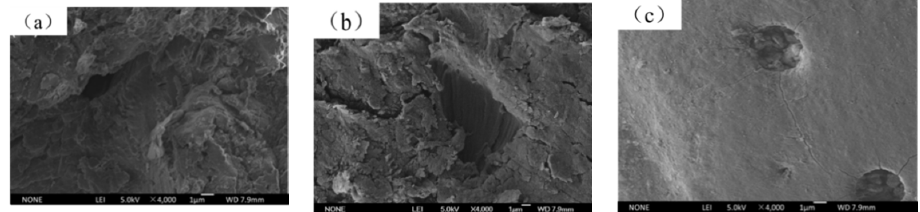
Figure 15. Microstructure of T26 polyurea coating after explosion: ( a ) section area I; ( b ) explosion source center area II; ( c ) coating edge area III.